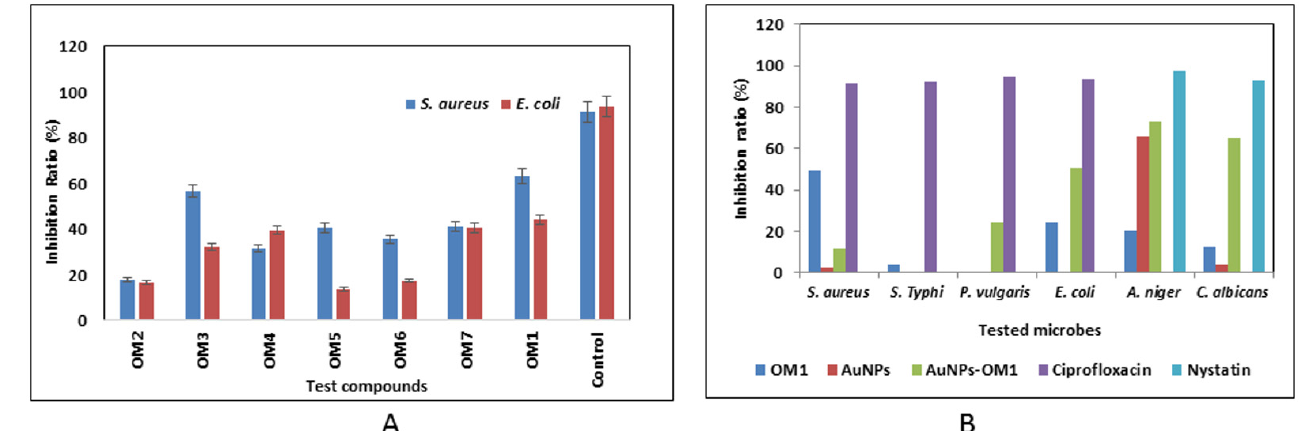
Figure 2. In vitro antimicrobial activity. ( A ) Antibacterial activity of different purified compounds, compared to control (ciprofloxacin). ( B ) Antibacterial and antifungal activity of compound OM 1 , compared with AuNPs and AuNPs-OM 1 .